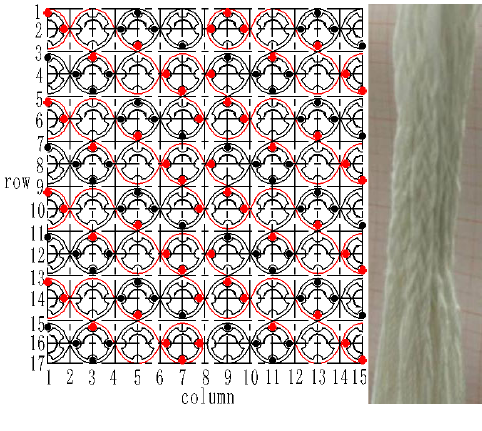
( b ) 64 horn gears mounted on track disc. Figure 7. Three ‐ dimensional square rotary braiding machine [24].